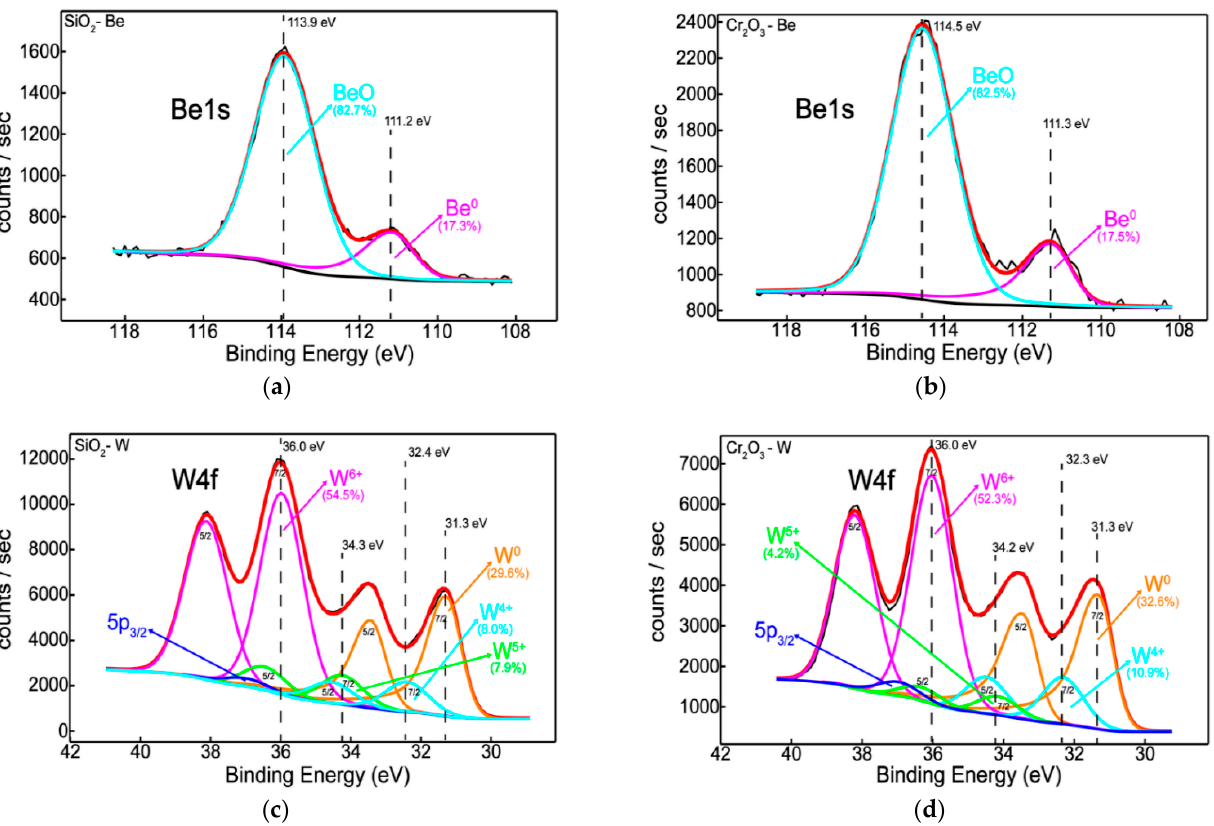
Figure 4. Be1s and W4f XPS peak-fitted spectra for Si- ( a )—B3, ( c )—B2 and Cr, ( b )—A3, ( d )—A2-based systems.